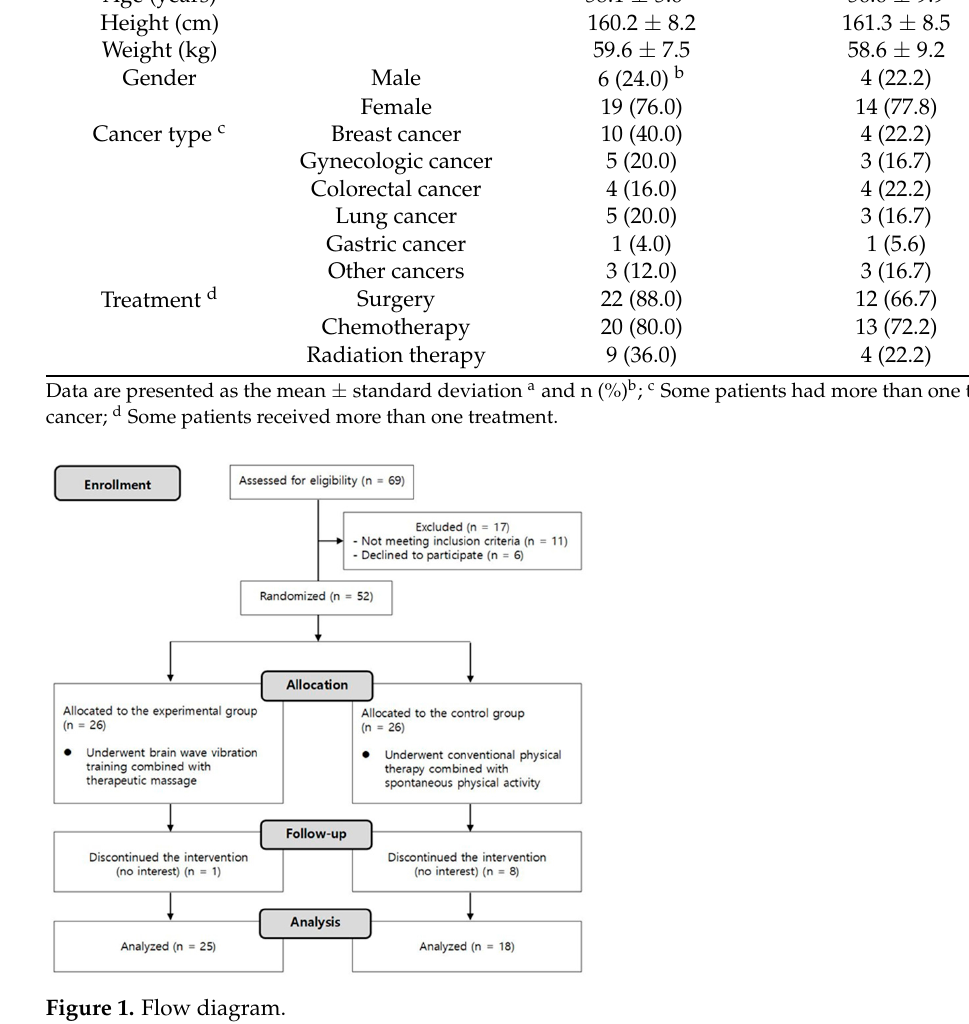
Table 1. Demographic and clinical characteristics of participants (N = 43).